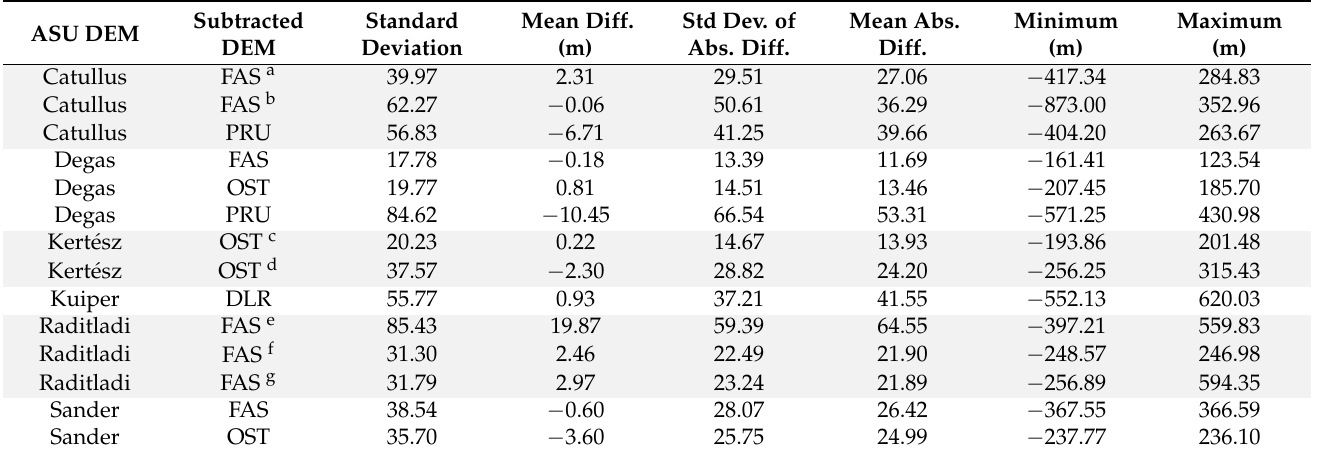
Table 5. Summary of differences between ASU DEMs and overlying DEMs.